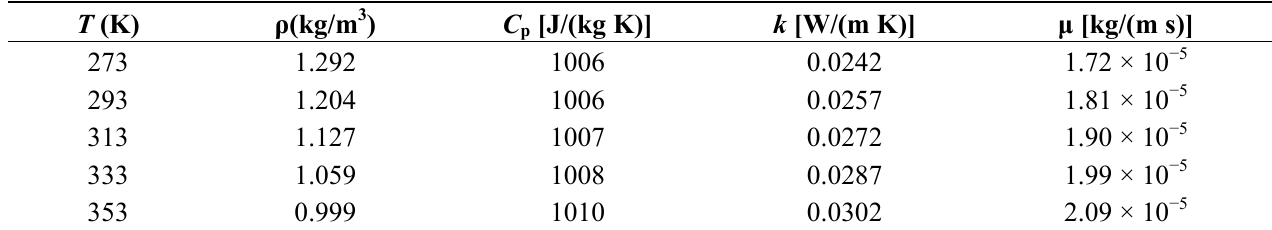
Table 1. Physical properties of air at 1atm